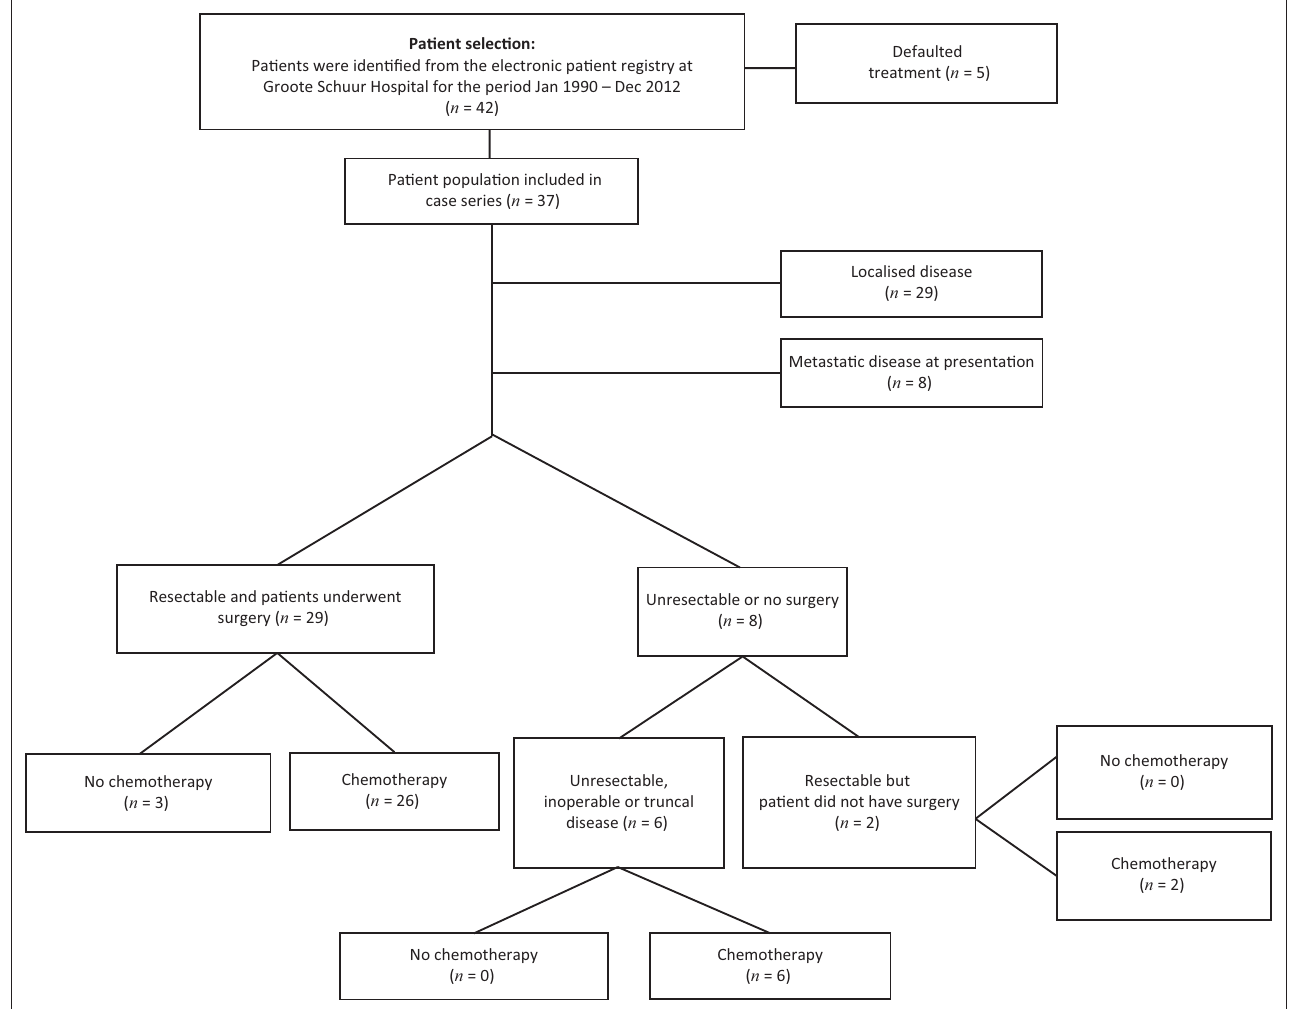
FIGURE 2: Flow diagram depicting patient identification, presentation and